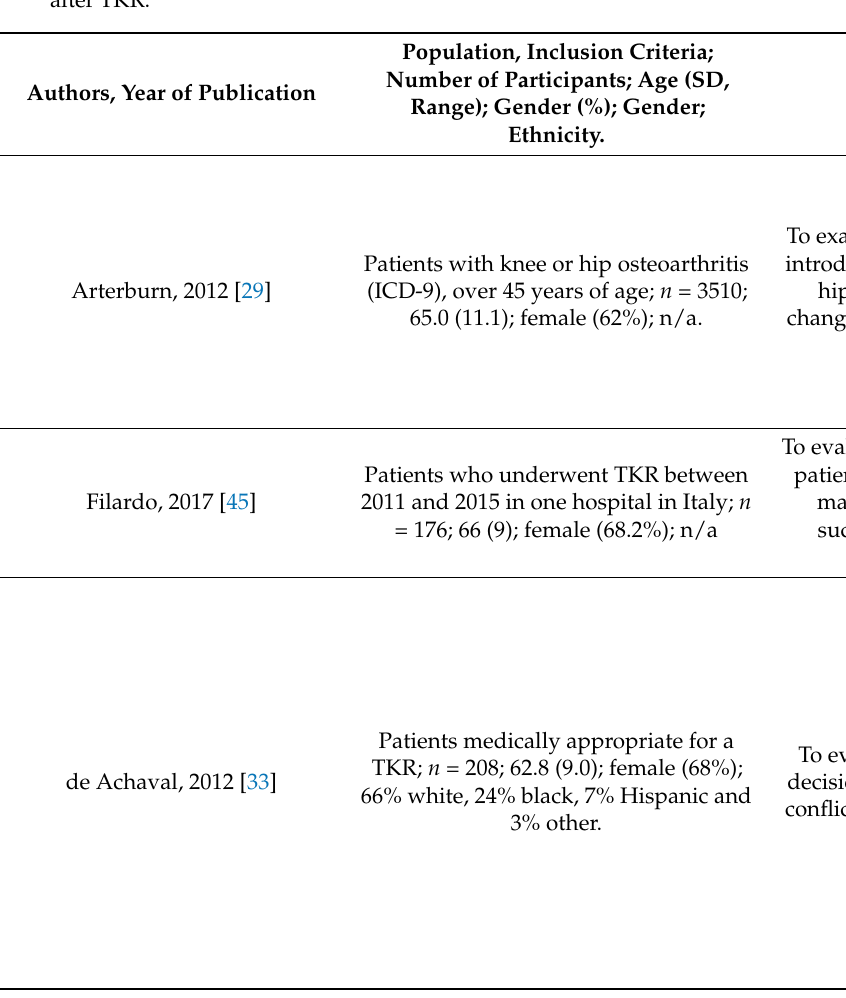
Table 2. Characteristics of the included manuscript for RQ2: How are shared decision making (SDM) processes supported among patients, regarding the three key decision moments before and after